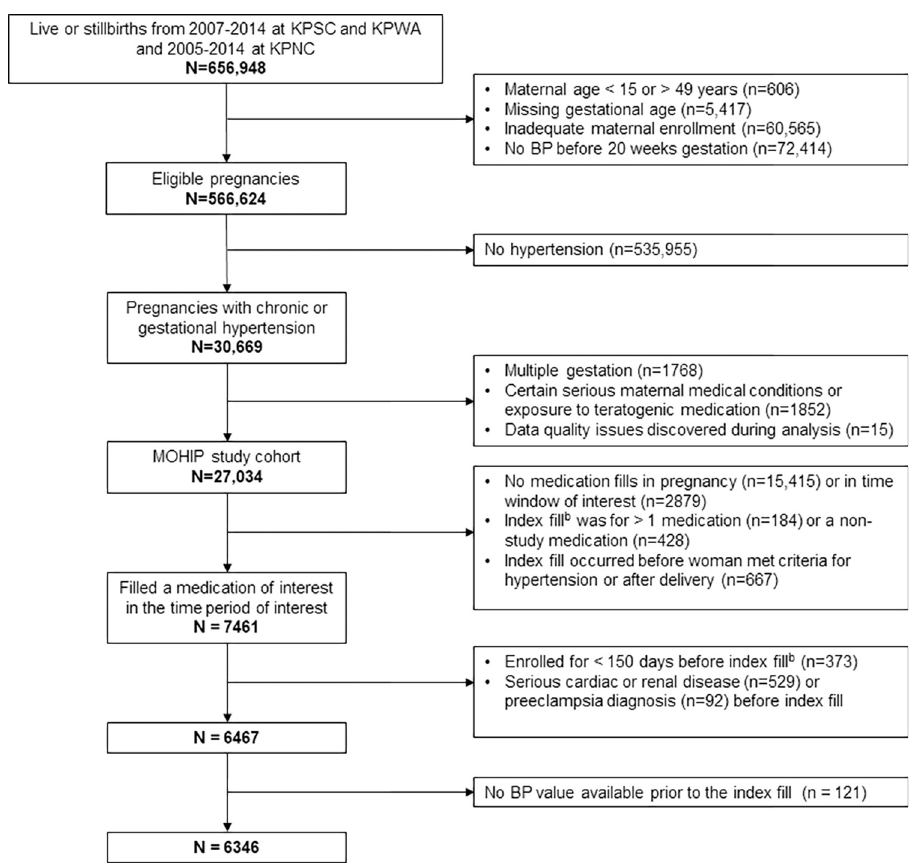
Fig 1. Impact of inclusion and exclusion criteria on study population. a Abbreviations: BP, blood pressure; KPNC, Kaiser Permanente Northern California; KPSC, Kaiser Permanente Southern California; KPWA, Kaiser Permanente Washington. a A woman may meet more than one exclusion criterion within a box. Detailed information about inclusion and exclusion criteria is found in S1 Table in S1 File. b The index fill was defined as the earliest fill after